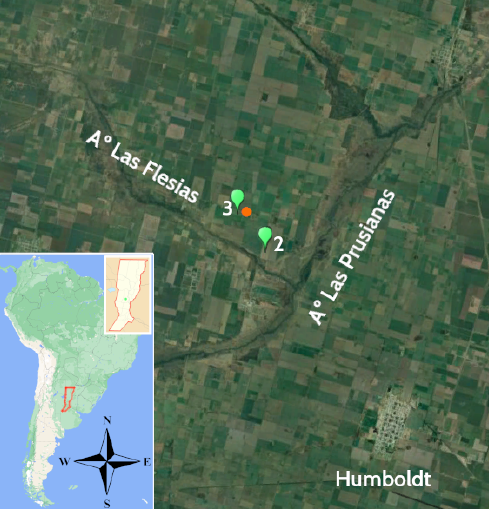
Figure 7. Location of the study site. The IoT device installed in the field above the soil surface counts,